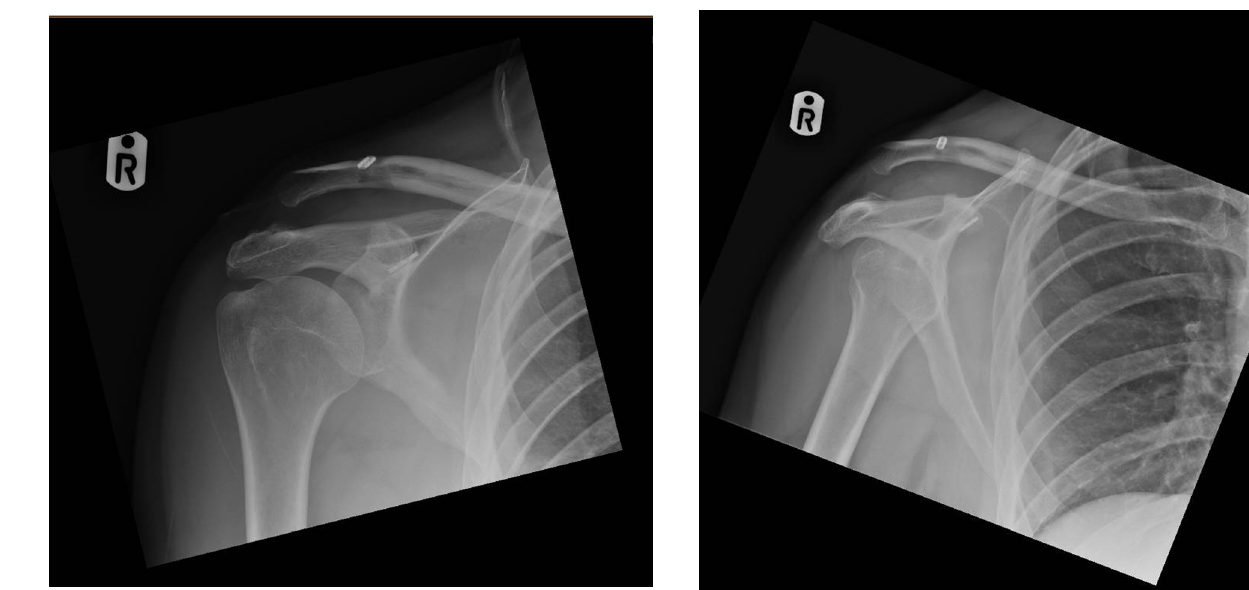
Figure 3. Medial subluxation of the coracoid button, 3 months post- operatively due to medial coracoid tunnel